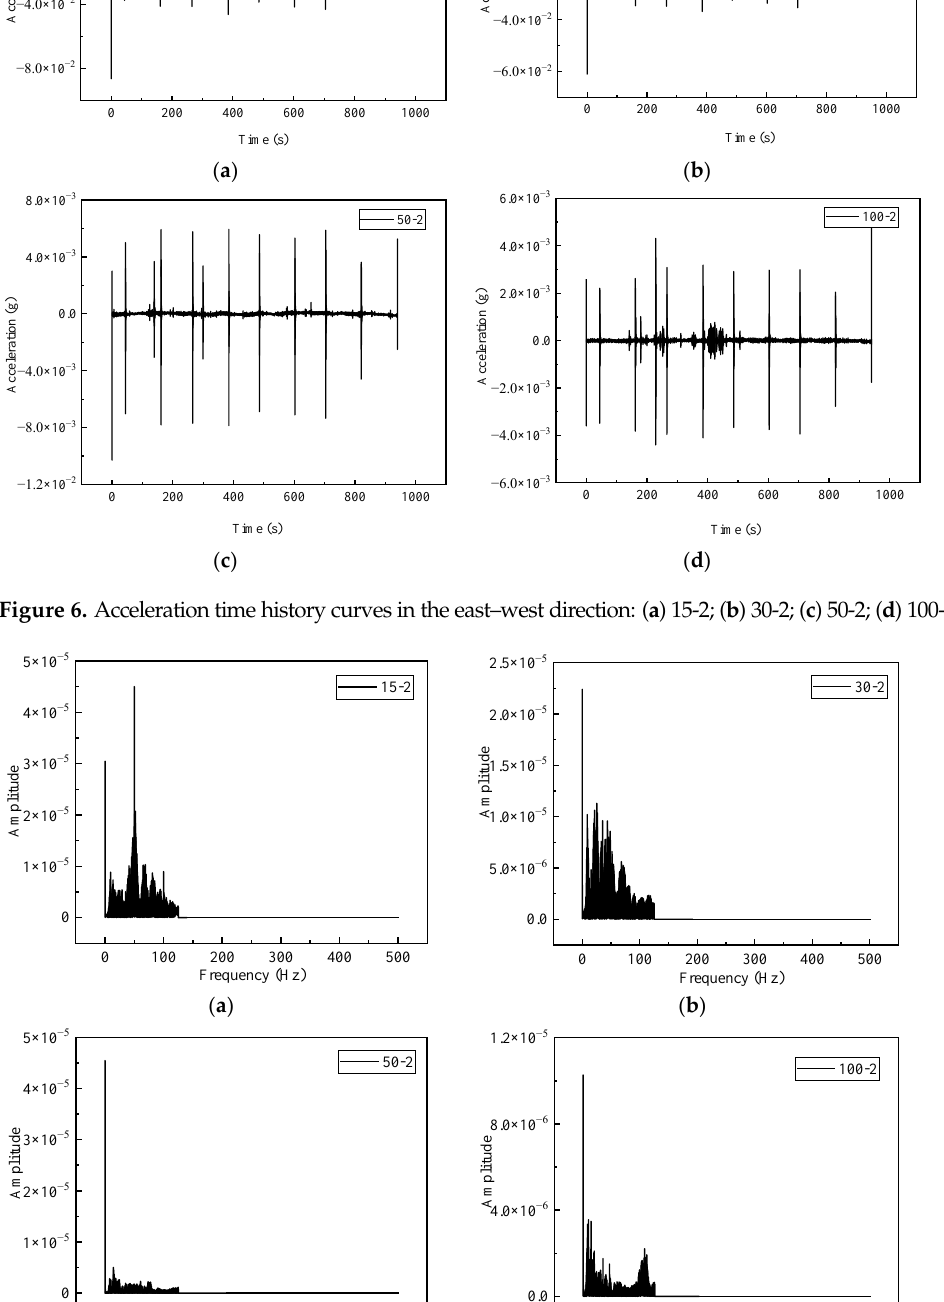
Figure 7. Fourier spectrum curves of acceleration in the east–west direction: ( a ) 15-2; ( b ) 30-2; ( c ) 50-2; ( d ) 100-2.